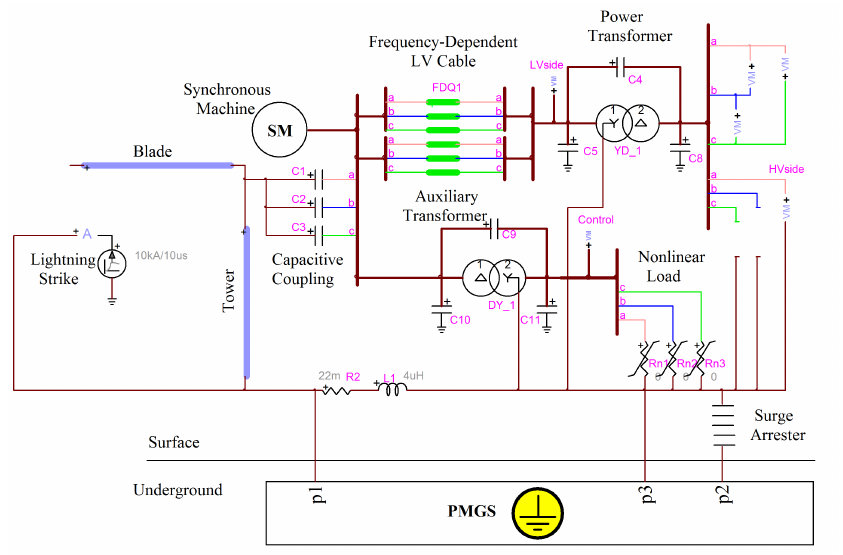
Figure 11. EMTP-RV Circuit of the comprehensive wind turbine model with PMGS.